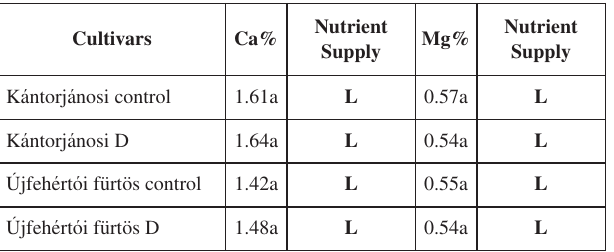
Table 4 Effect of frost on leaf Ca and Mg content Cultivars